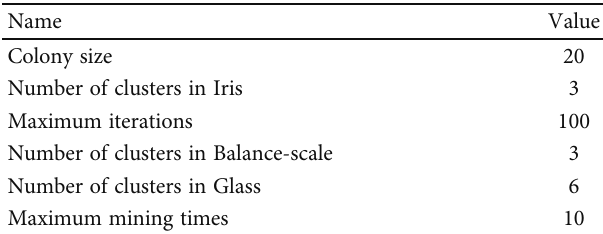
Figure 5: Change of fi tness iteration trend before and after improved bee colony algorithm. Table 5: Parameter of improved